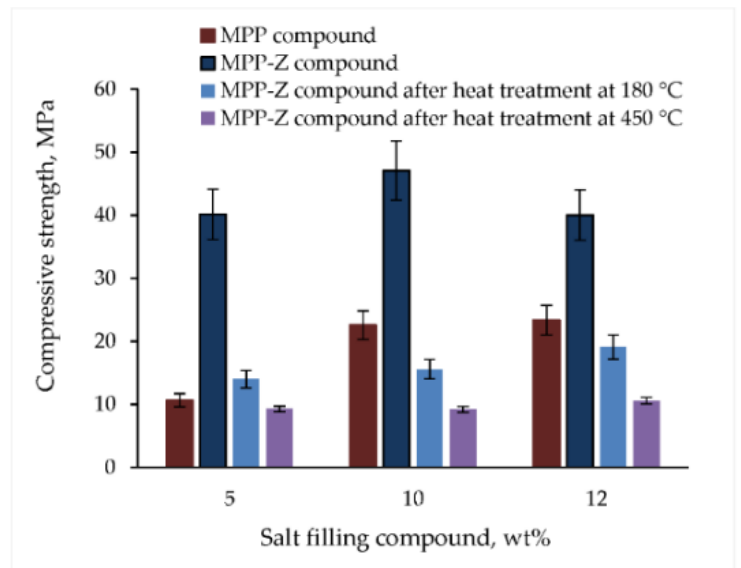
Figure 3. Compressive strength of MPP compound containing spent electrolyte imitator.